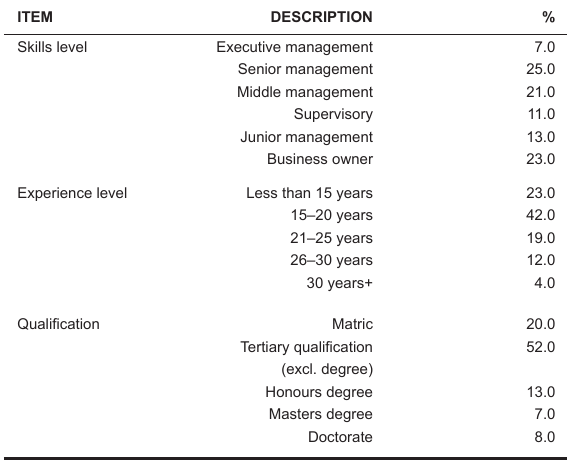
TABLE 1 Respondent skill, experience levels and qualifications whilst in South